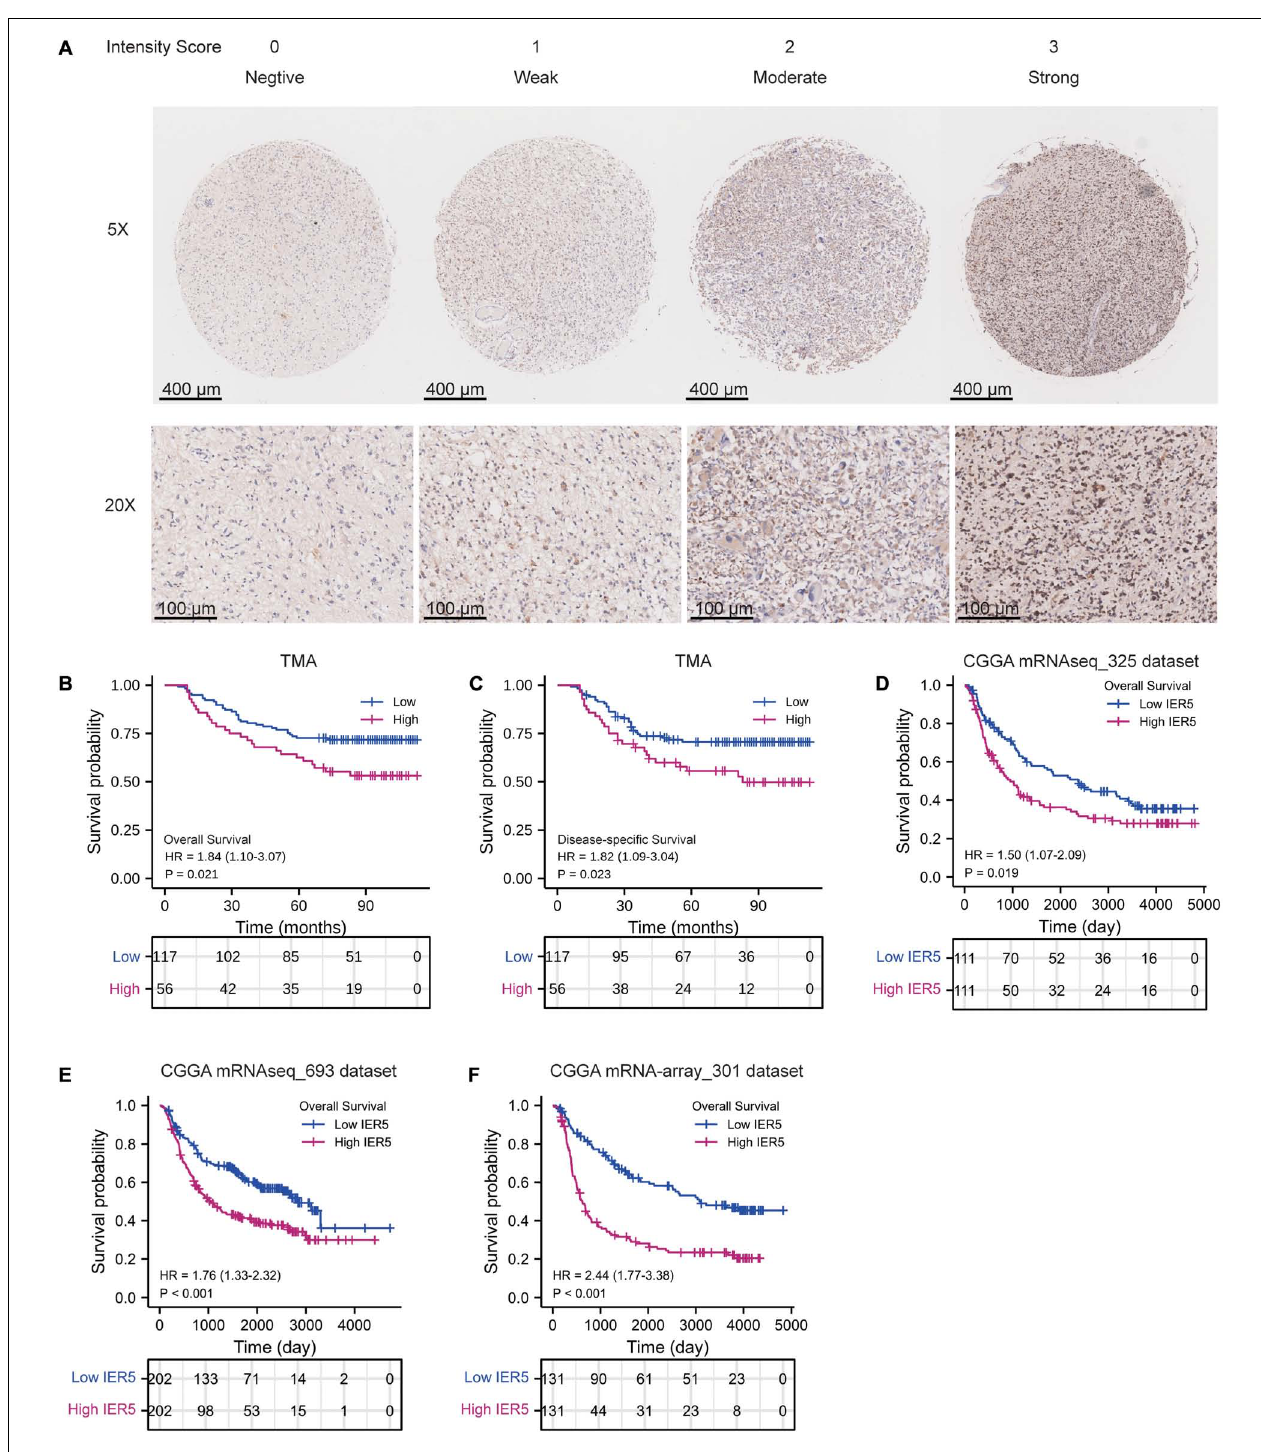
FIGURE 6 | Immunohistochemistry of IER5 expression in the glioma tissue microarray cohort and the validation of prognosis value of IER5 expression in Chinese Glioma Genome Atlas (CGGA) datasets. (A) Representative images of IER5 staining in the negative, weak, moderate, and strong expression groups. (B) Kaplan–Meier survival curves of overall survival stratified by IER5 protein expression. (C) Kaplan–Meier survival curves of disease-specific survival stratified by IER5 protein expression. (D–F) Kaplan–Meier survival curves of overall survival stratified by IER5 expression in three independent datasets of CGGA.